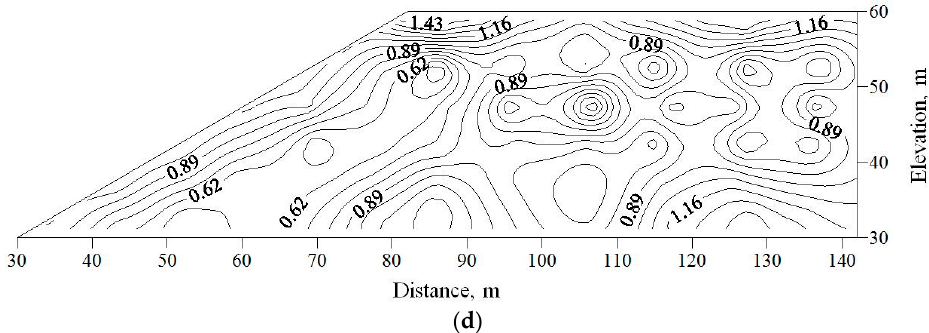
Figure 10. The distribution regularity of acceleration amplification coefficient of the slope on spatial domain (where ξ = 0.4); ( a ) K = 0.1; ( b ) K = 0.5; ( c ) K = 2; ( d ) K = 4.